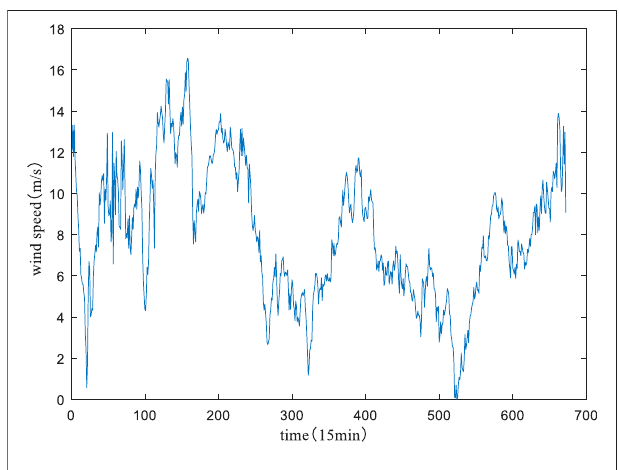
FIGURE 3 | Dataset of wind